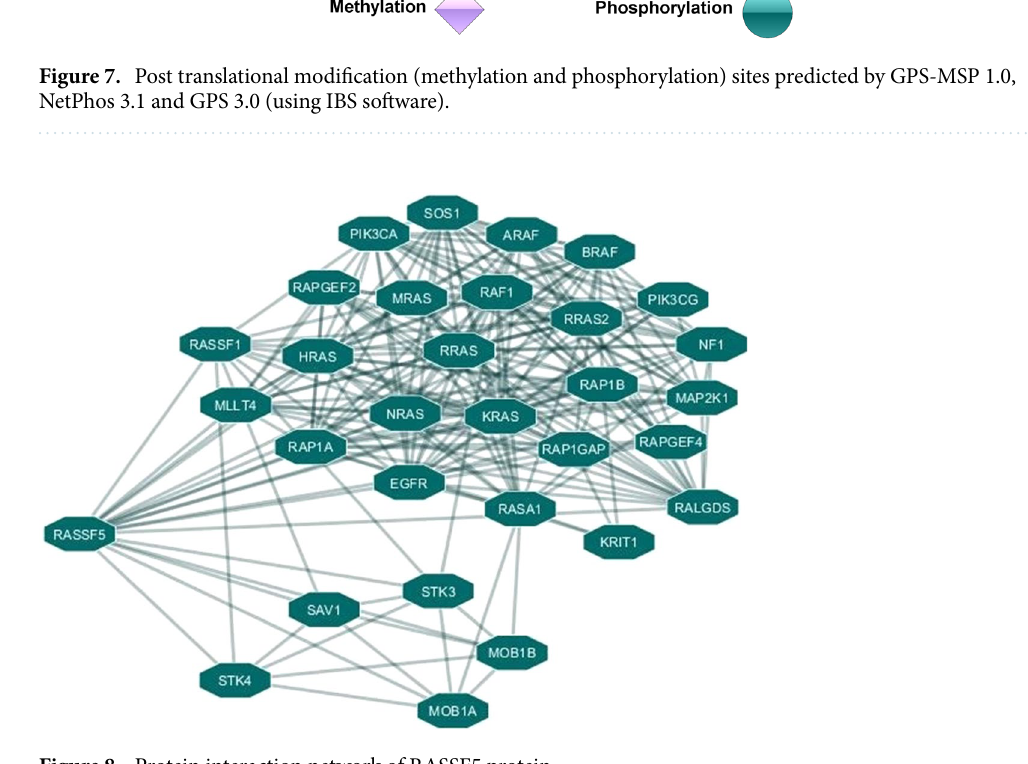
Figure 8. Protein interaction network of RASSF5